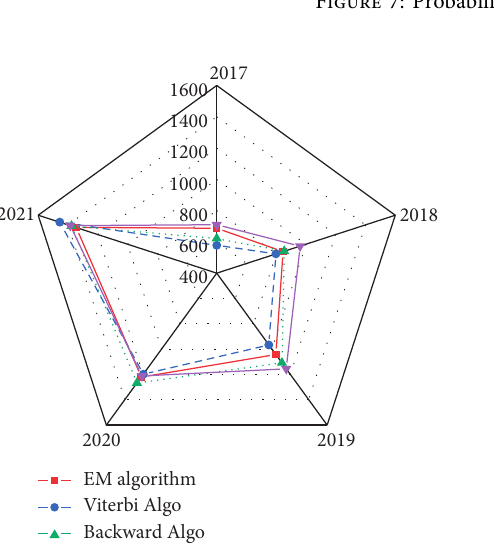
Figure 7: Probability statistics of different